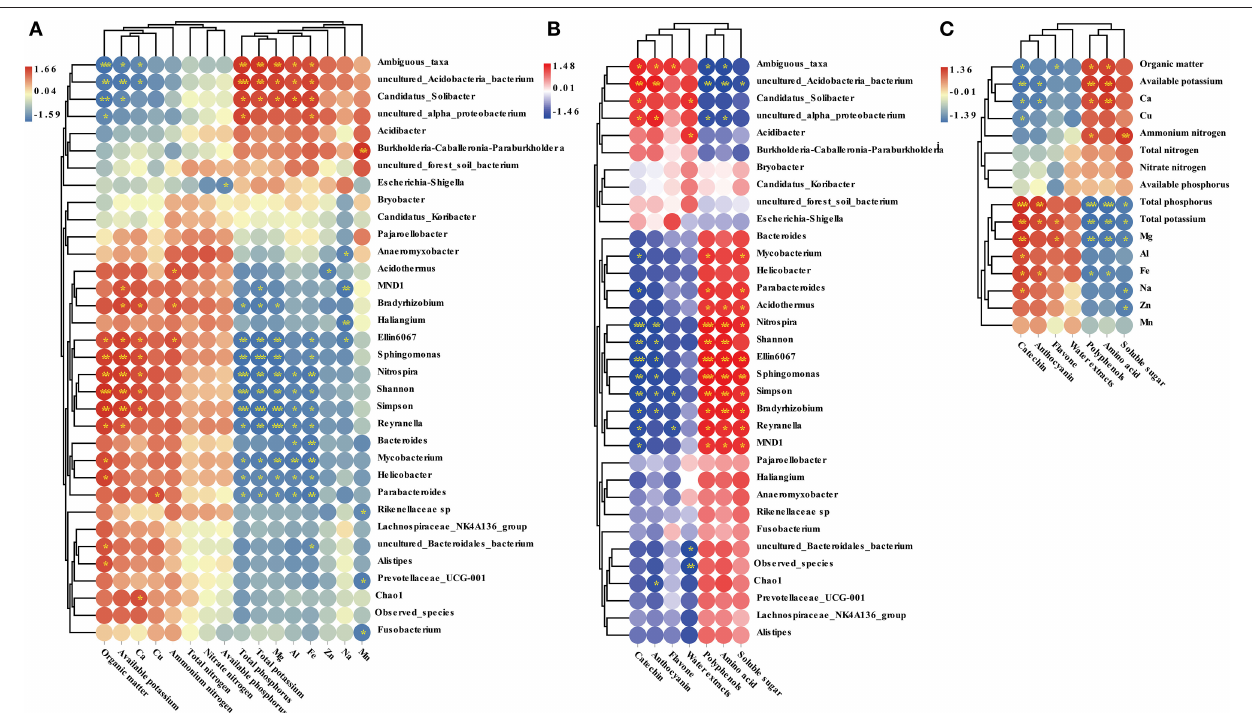
FIGURE 10 | Correlation analysis between soil properties and microbial indicators (A) , between Pu-erh active ingredient content and microbial indicators (B) , between soil properties and Pu-erh active ingredient content (C) . The blue color block indicates that there is a negative correlation between different samples, while the red color block indicates that there is a positive correlation between different samples. *Indicates a significant correlation between samples at the level of P < 0.05, **Indicates a significant correlation between samples at the level of 0.01 < P < 0.01, while *** indicates a significant correlation between samples at the level of P <